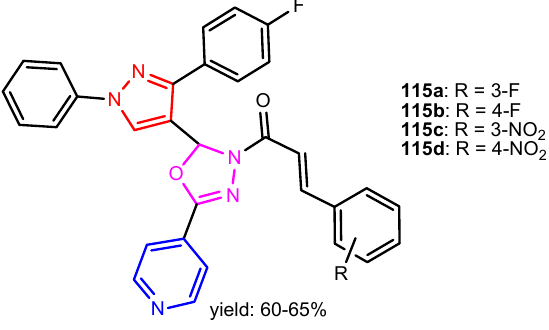
Sa: Staphylococcus aureus MTCC 96; Sp: Staphylococcus pyogenes MTCC 442; Ec: Escherichia coli MTCC 443; Pa: Pseudomonas aeruginosa MTCC 1688; Ca: Candida albicans MTCC 227; An: Aspergillus niger MTCC 282; Ac: Aspergillus clavatus MTCC 1323.